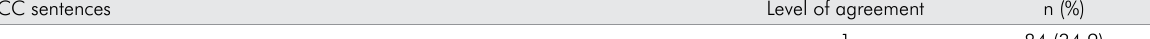
Table 3. ICCC sentences and level of agreement (1 - totally disagree, 2 - partially disagree, 3 - do not know, 4 - partially agree, 5 - totally agree).